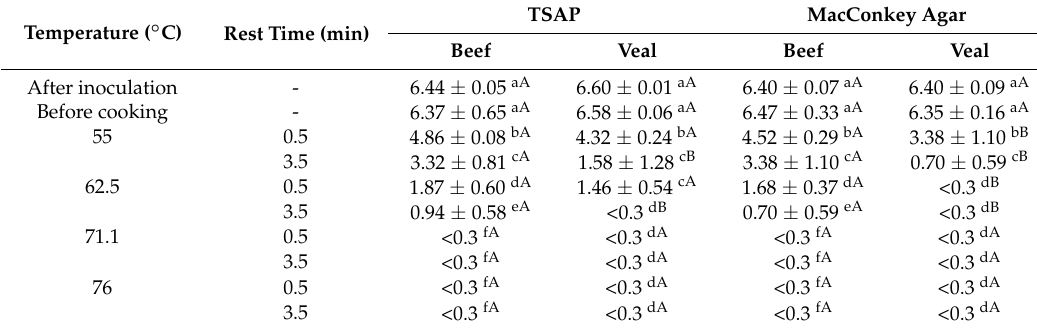
Table 7. Total bacterial and Escherichia coli O157:H7 populations (log CFU/g; ± standard deviation) that were recovered from tryptic soy agar plus 0.1% sodium pyruvate (TSAP) and MacConkey agar, respectively, in beef and veal samples before and after double pan-broiling to 55, 62.5, 71.1, and 76 ◦ C with a 0.5- or 3.5-min